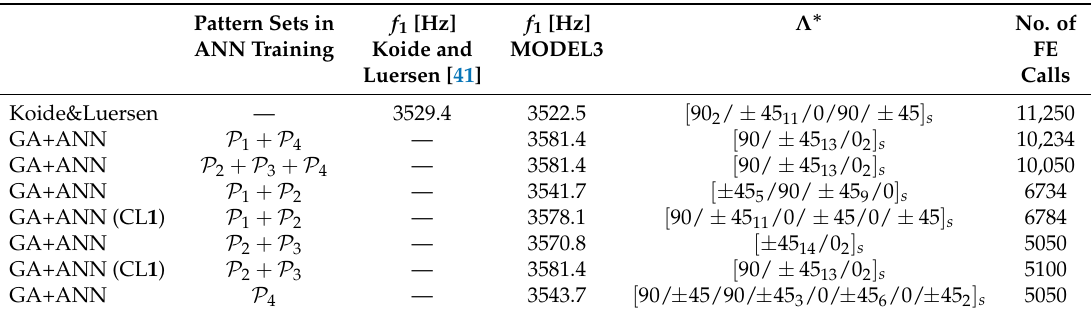
Table 2. Comparison of optimized